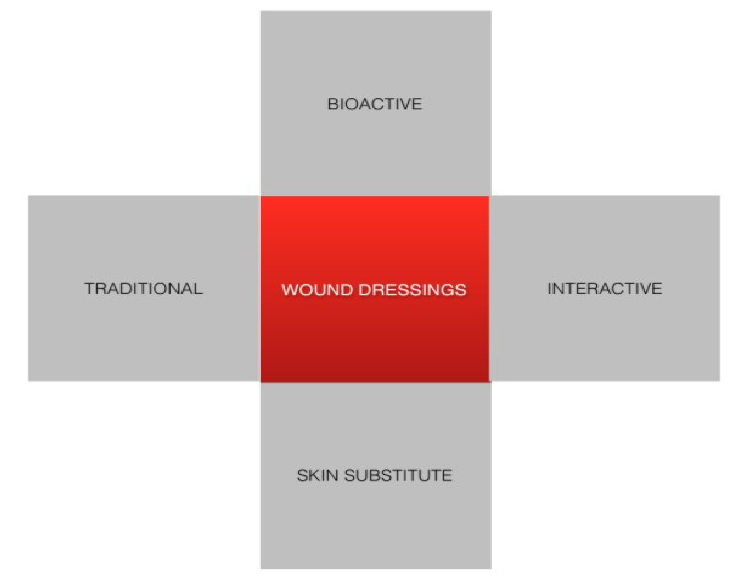
Figure 8. Classification of wound dressings according to their applications.